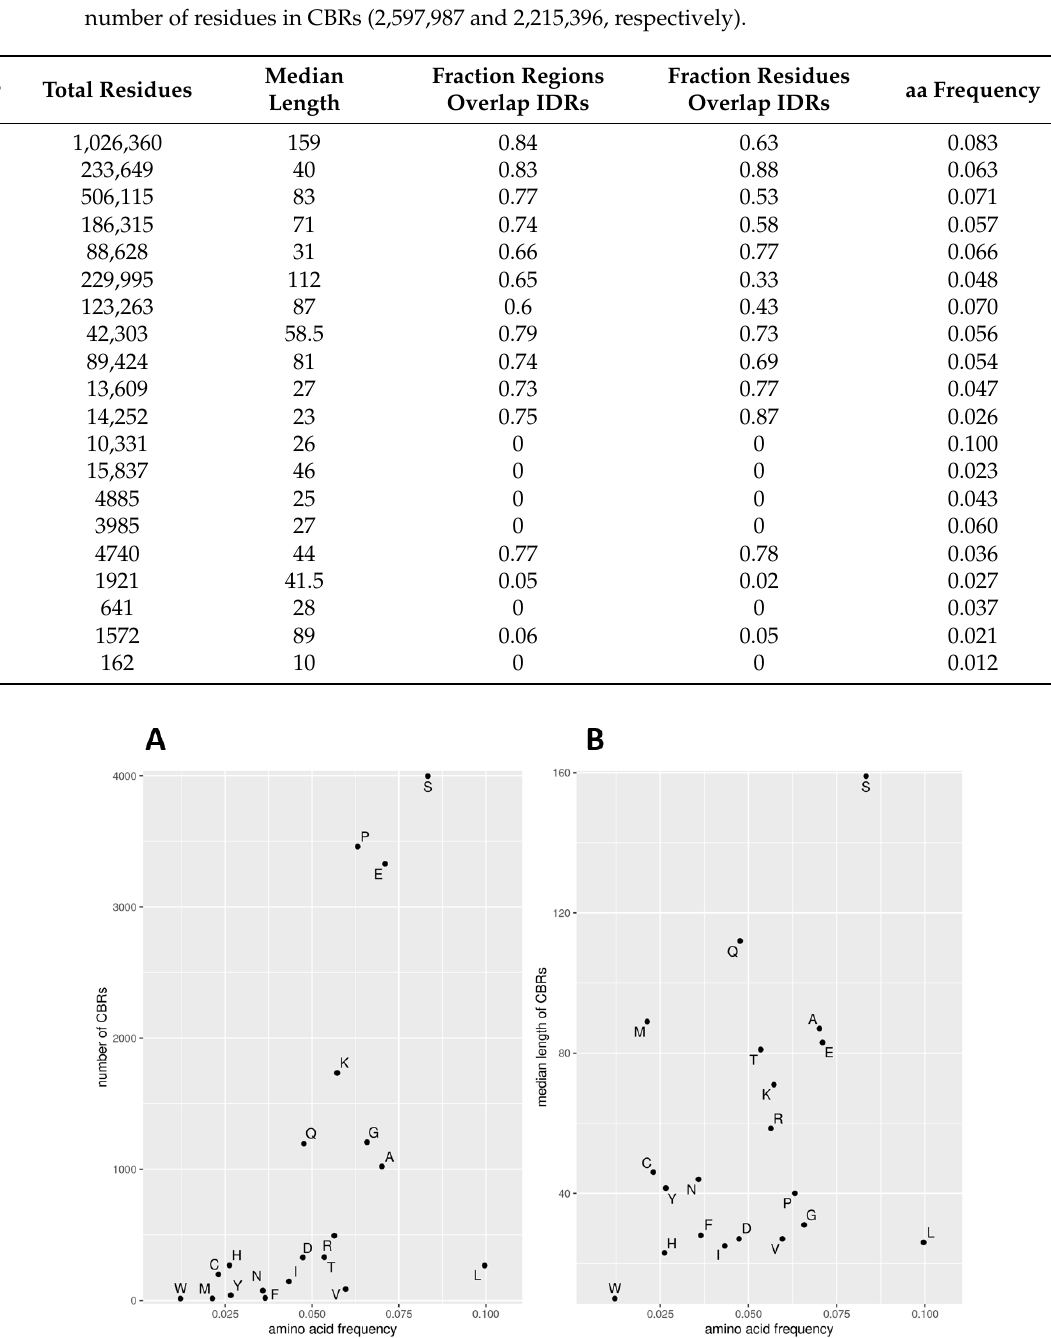
(1021 times) and have longer median length (87). Table 1. Properties of CBRs by type. Columns indicate type, number of CBRs, total of residues, median length, fraction of overlap to IDRs in numbers of regions and in residues, and general frequency of the amino acid in the human proteome (shown for comparison). Note that CBRs of different types might overlap and thus the total number of residues in this table is higher than the number of residues in CBRs (2,597,987 and 2,215,396, respectively).